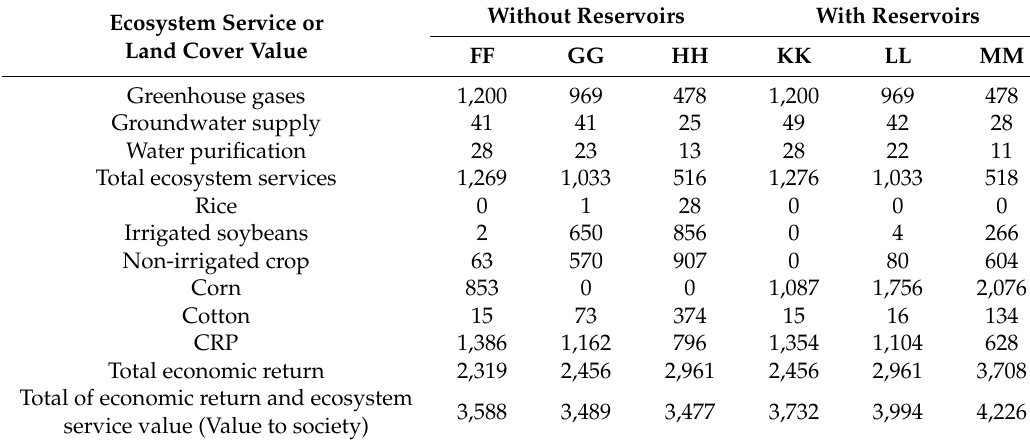
service value (Value to society) Table 5. Present value of economic returns and ecosystem services for select points on the efficiency frontier optimizing greenhouse gases value (in millions of 2013 constant